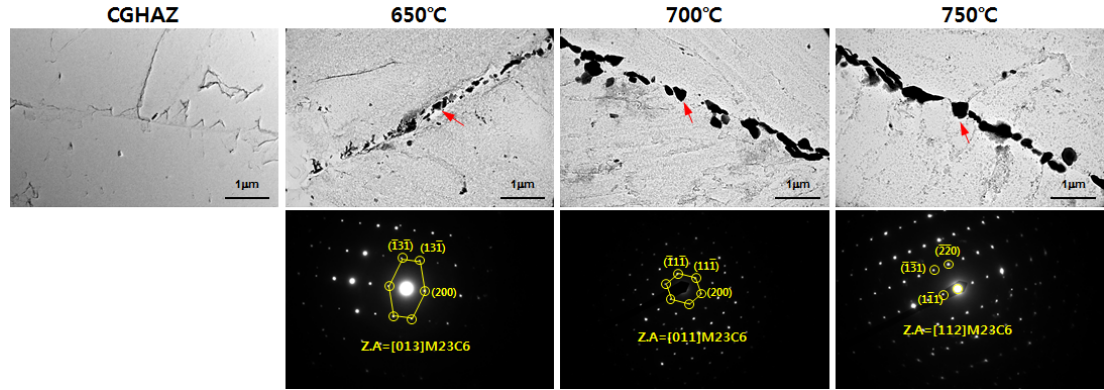
Figure 6. TEM microstructures and diffraction patterns at the regions denoted by arrows at various PWHT temperatures.